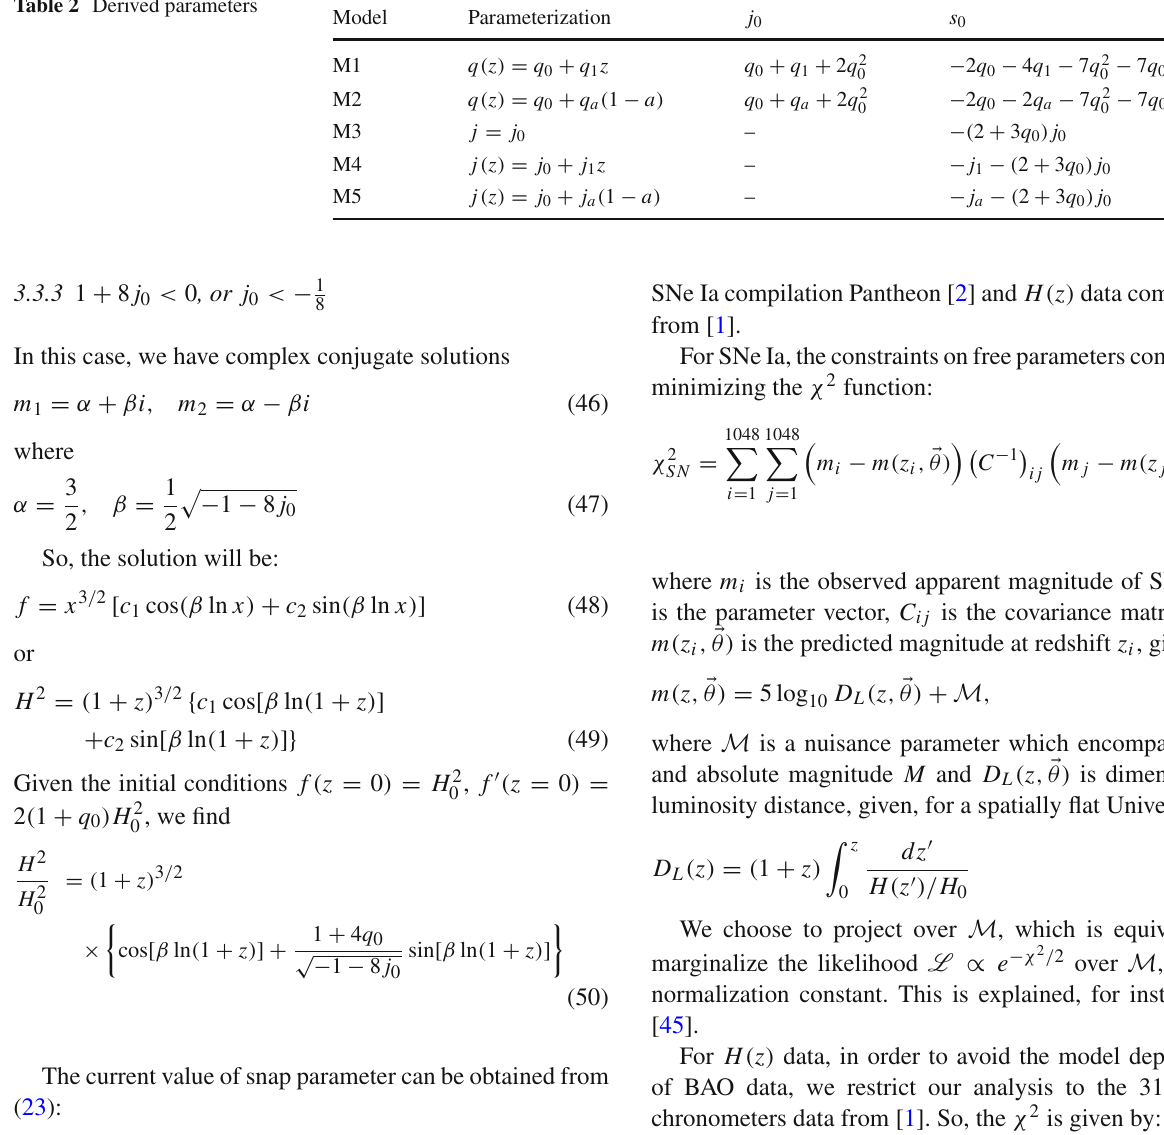
Table 2 Derived parameters